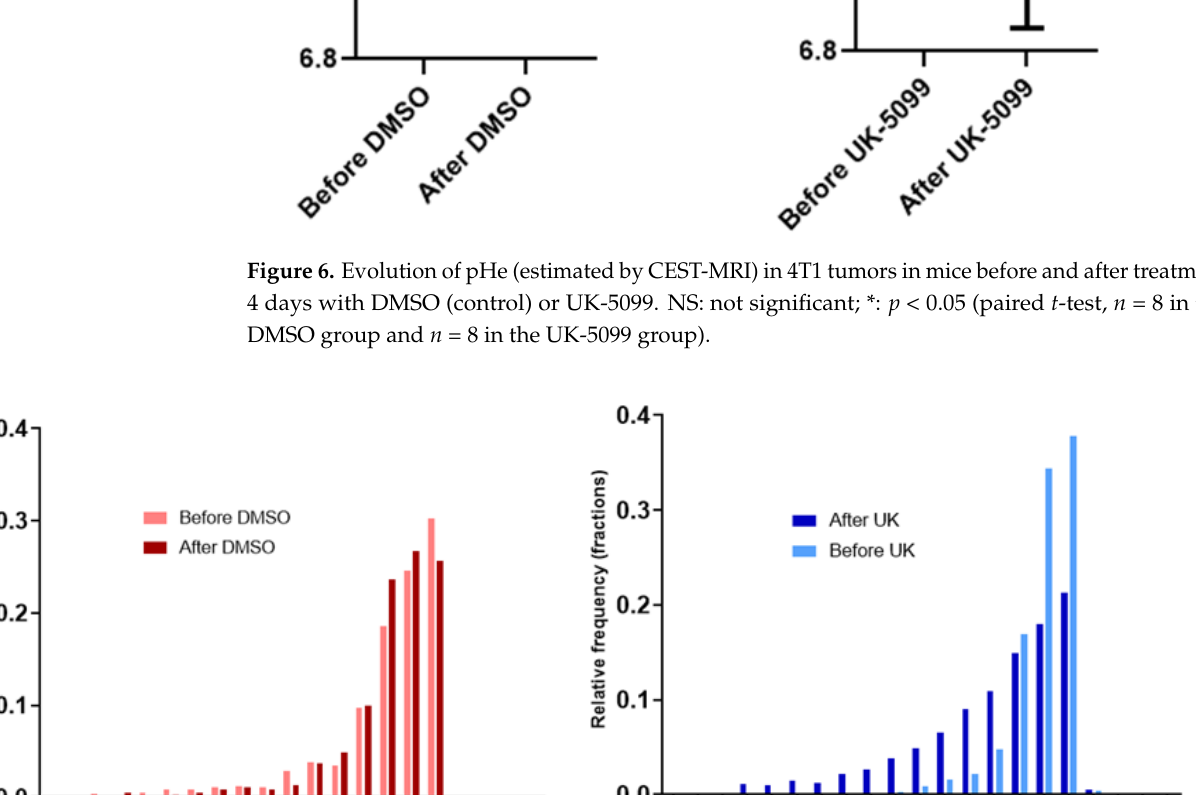
Figure 7. Histograms of distribution all pHe values recorded in individual voxels using CEST-MRI. Left : pHe values before